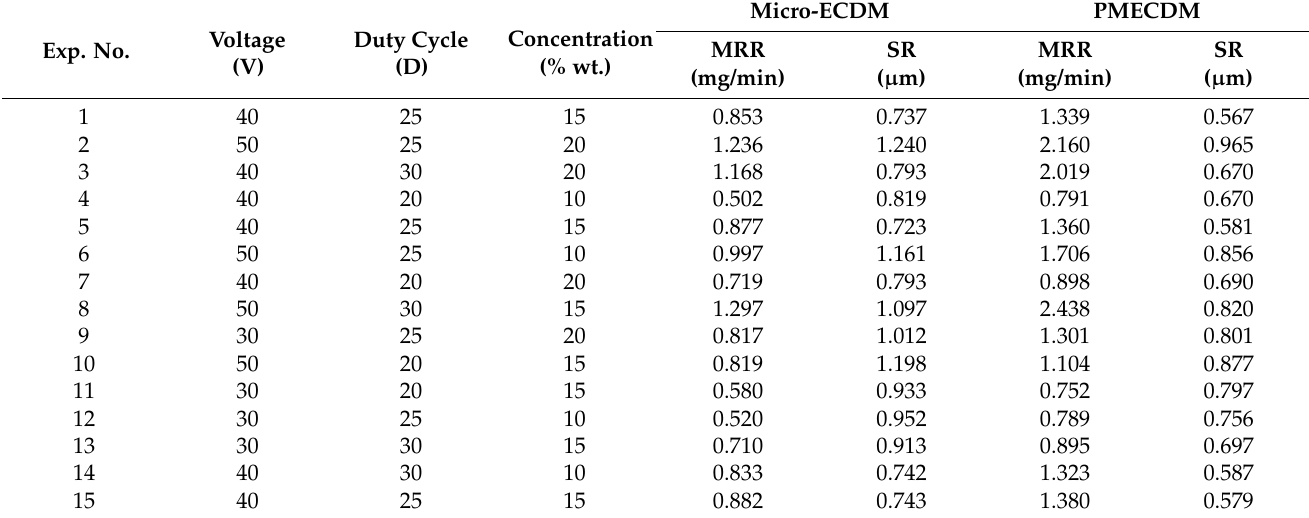
Table 1. Parameter settings of experimental runs and